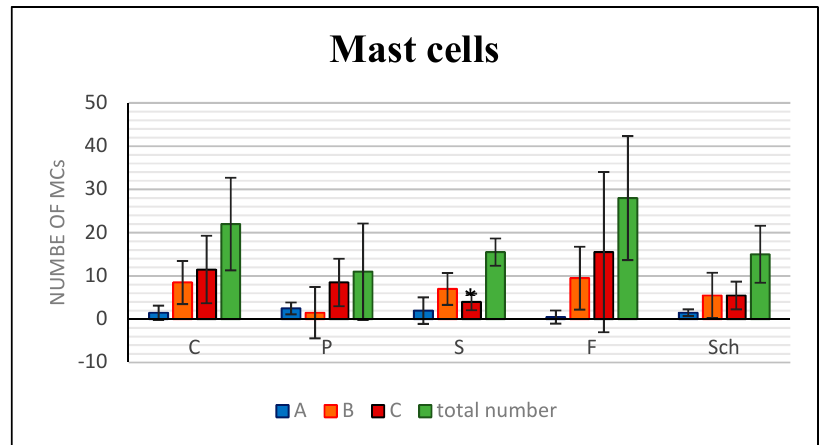
Figure 7. Analysis of mast cells (MCs) number based on their labeling by Toluidine Blue. Control (C), palm oil (P), safflower oil (S), fish oil (F), and Schizochytrium extract (Sch) treated animals were analyzed 12 days after skin excision. Number of mast cells in the superficial layer (A, blue), in the middle (B, orange) and in the deep layer of the dermis (C, red). Sum of positive cells (green, total). Average values and standard deviations are displayed in the graph. (* p < 0.05; unpaired t -test; n = 5).